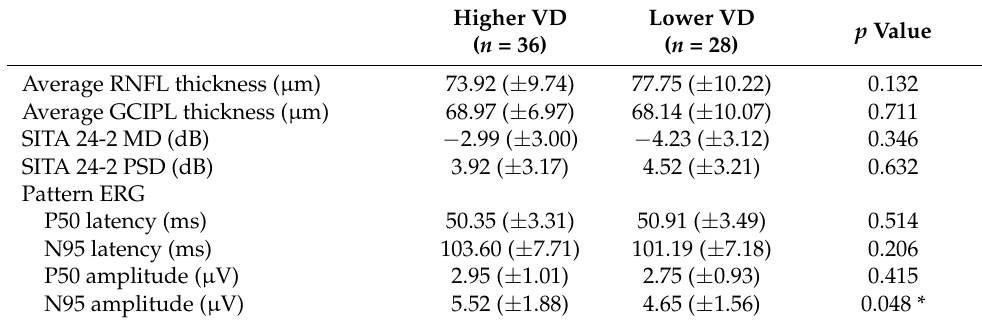
Table 2. Comparisons of functional and structural parameters between higher and lower groups of average macular VD † in mild to moderate glaucoma (MD ≥ − 12 dB).